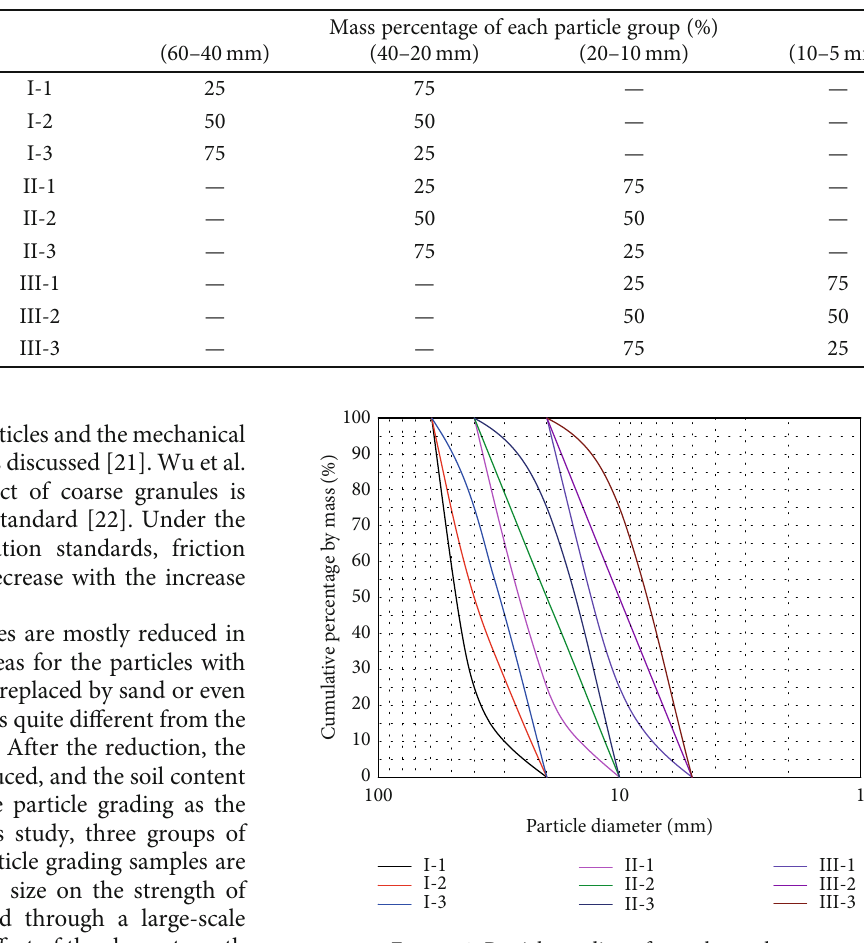
Table 1: Pebble gravel sample preparation.